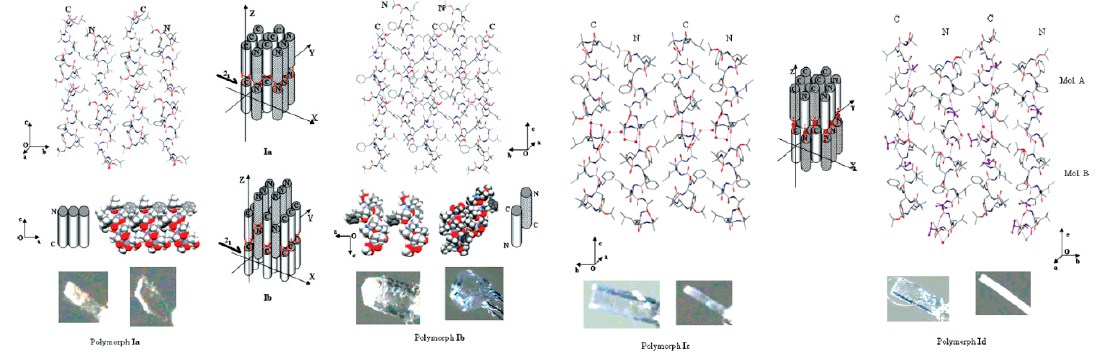
Figure 10. Display and packing of a decapeptide’s polymorphs. Reprinted with permission from [15]. Copyright 2008 American Chemical Society (USA).